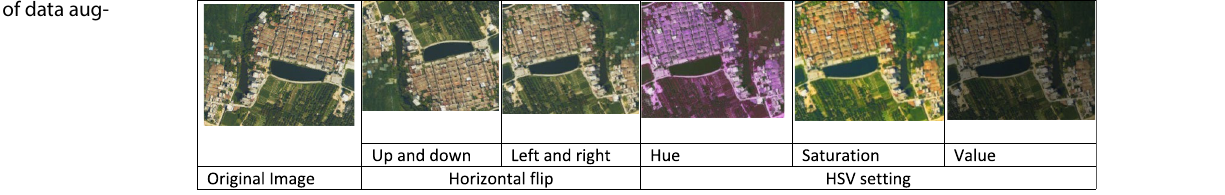
Fig. 6 Example of data aug- mentation